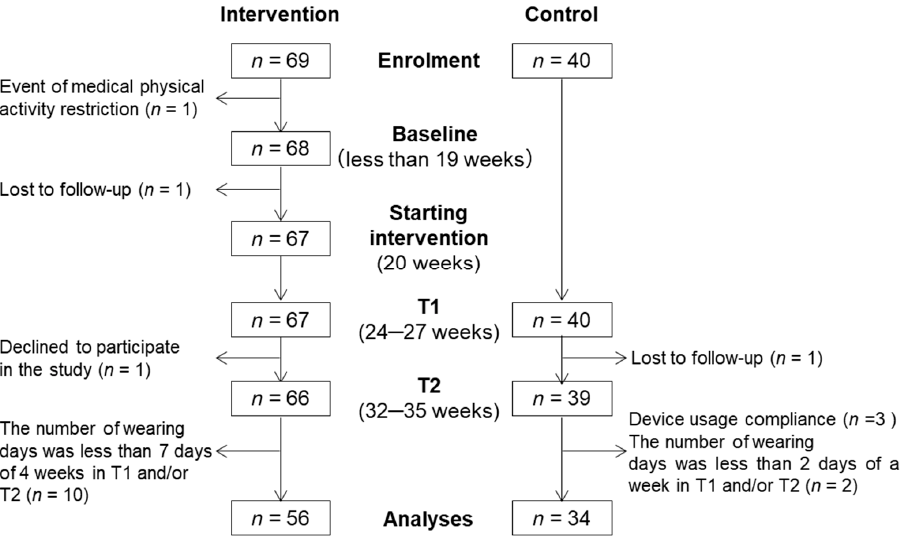
Figure 1. Flowchart of the selection of the study participants.